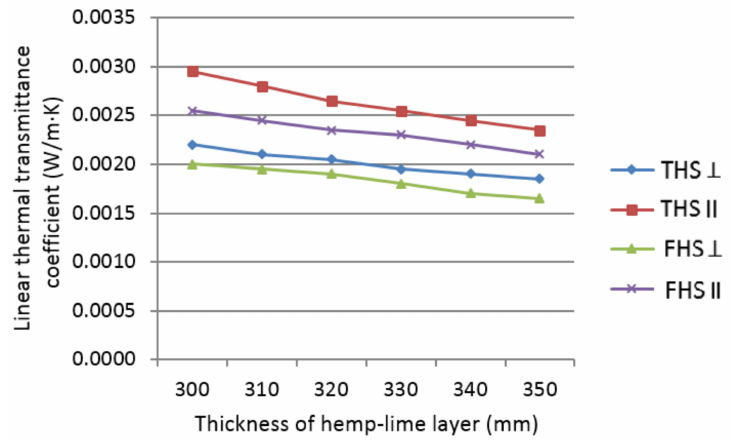
Figure 11. Linear thermal transmittance coefficient of walls insulated with the analyzed composites, depending on the thickness of the hemp-lime composite